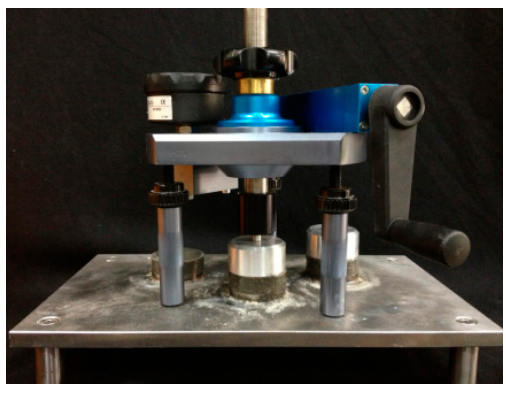
Figure 3. Setup for bond strength tests.